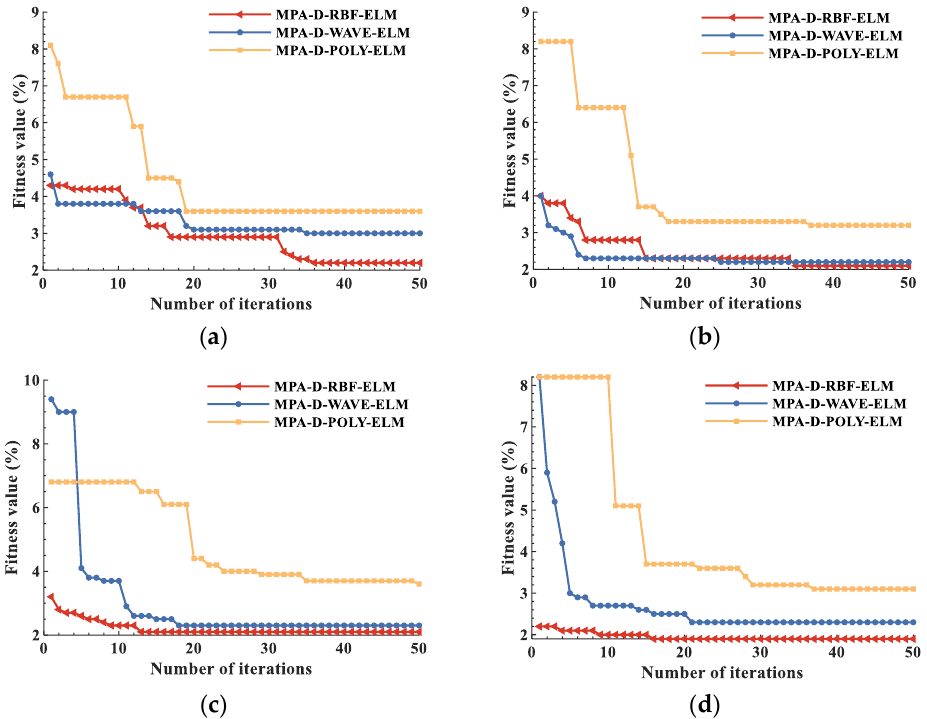
Figure 7. Iteration curves of different DK-ELM optimized by MPA (Western Reserve University): ( a ) Iteration curves of different DK-ELM optimized by MPA (The model of one layer AE-ELM). ( b ) Iteration curves of different DK-ELM optimized by MPA (The model of two layers AE-ELM). ( c ) Iteration curves of different DK-ELM optimized by MPA (The model of three layers AE-ELM). ( d ) Iteration curves of different DK-ELM optimized by MPA (The model of four layers AE-ELM).